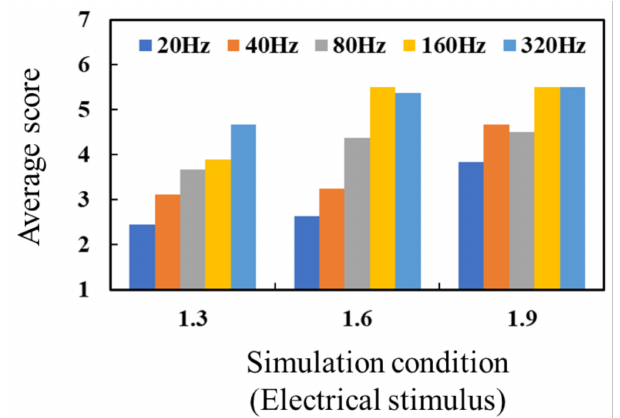
Figure 8. Average score of perceived pressure via the electrical stimulus, with 1 meaning vibration and 7 meaning